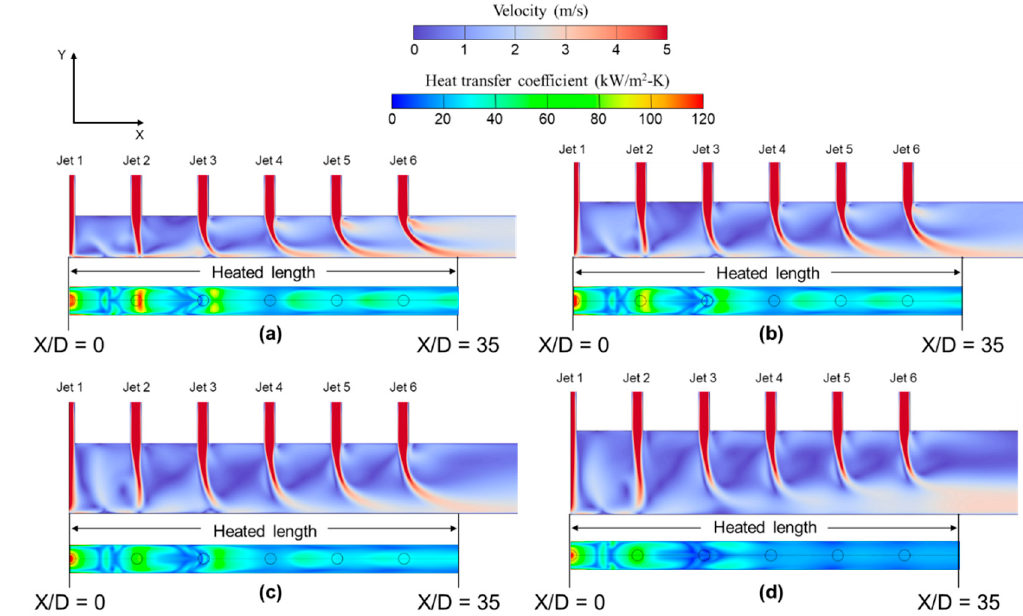
(cid:48)(cid:48) = 18 W/cm 2 and V jet = 5 m/s for